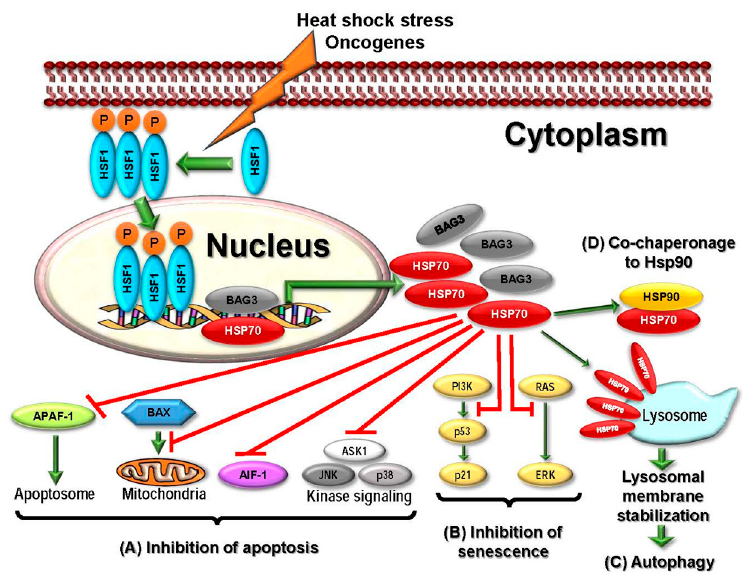
Figure 6. Diverse roles of HSP70 in carcinogenesis in response to stress. Activation of HSF1 in response to heat shock stress and oncogenic activation (orange lightning) leads to overexpression of HSP70 and its co-chaperones (e.g., Bag3) promoting tumorigenesis through the following mechanisms: ( A ) Suppression of apoptosis: Hsp70 inhibits both intrinsic and extrinsic apoptotic pathways by blocking APAF1 recruitment to apoptosome, inhibiting BAX translocation to mitochondria, suppressing AIF-1 expression and other stress-induced kinases; ( B ) Bypass of senescence: HSP70 inhibits both p53-dependent and-independent senescence pathways; ( C ) Promotion of autophagy: Localization of HSP70 to the lysosomes in cancer cells stabilizes the lysosomal membrane to promote autophagy, and ( D ) Activation of additional HSPs: HSP70 serves as a co-chaperone to HSP90 and is required for the proper maturation of HSP90 client proteins such as HER2, AKT, and CRAF.